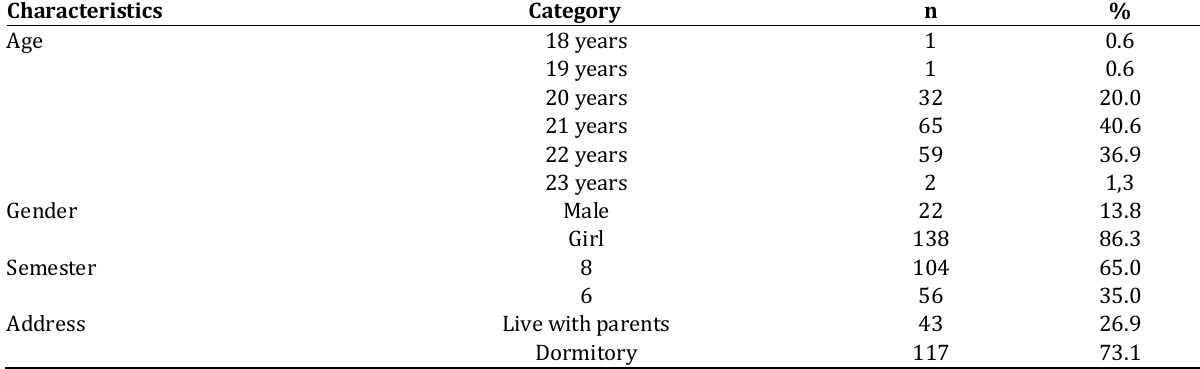
Table 1. Respondents’ Characteristics Characteristics